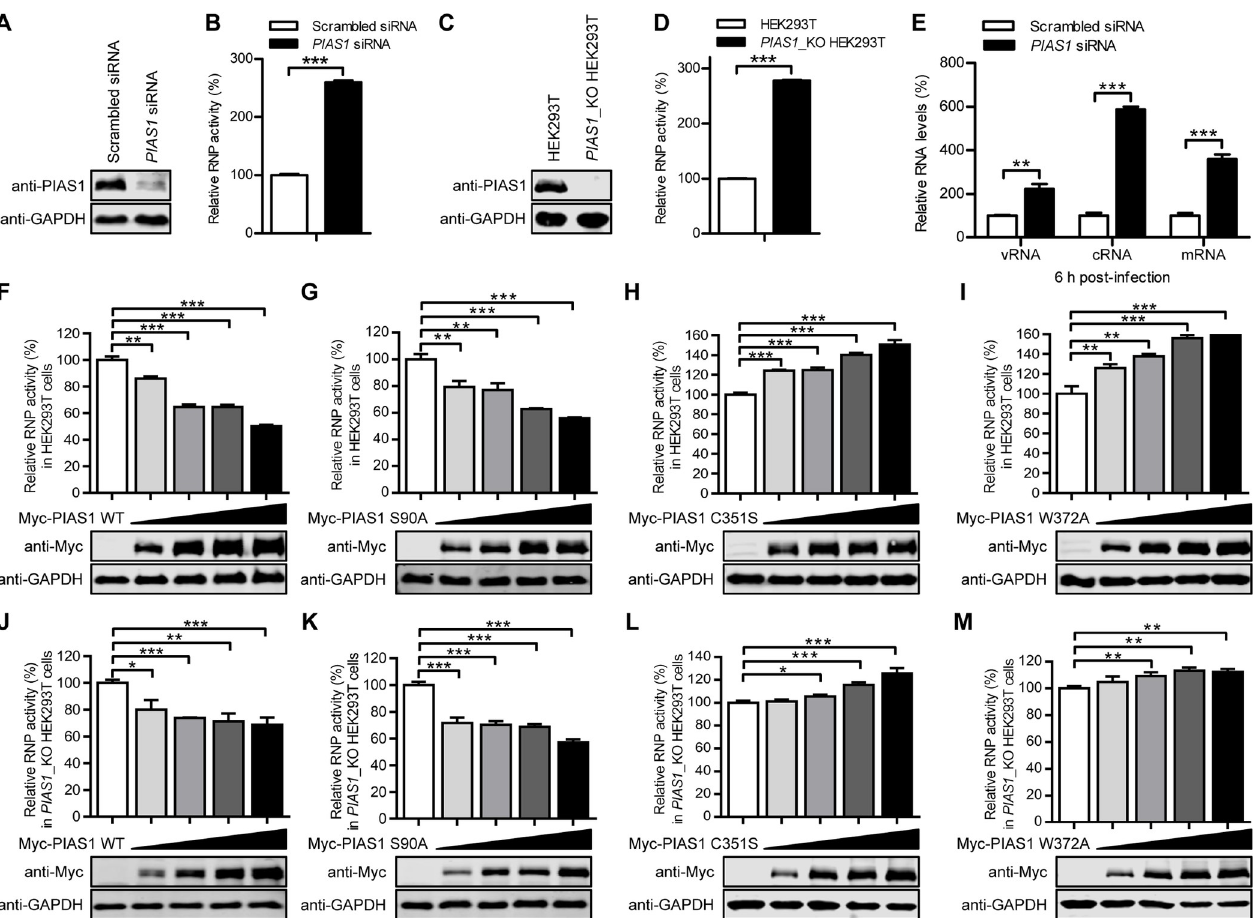
Fig 4. PIAS1 relies on its SUMO E3 ligase activity to suppress IAV transcription and replication. (A) siRNA knockdown of PIAS1 in HEK293T cells. HEK293T cells were transfected with PIAS1 siRNA or scrambled siRNA for 48 h. Knockdown of PIAS1 expression was confirmed by western blotting with a rabbit anti-PIAS1 pAb. (B) Minigenome assay in siRNA-treated HEK293T cells to determine the effect of endogenous PIAS1 on viral RNP activity. HEK293T cells treated with siRNA as in (A) were transfected with plasmids for the expression of four viral RNP proteins (WSNPB2, WSNPB1, WSNPA, and WSNNP), together with pHH21-SC09NS F-Luc and pRL-TK. Thirty-six hours later, a dual-luciferase assay was performed in which the relative firefly luciferase activity was normalized to the internal control, Renilla luciferase activity. ��� , P < 0.001. (C) Establishment of a PIAS1 _KO HEK293T cell line. The knockout of PIAS1 was confirmed by western blotting with a rabbit anti-PIAS1 pAb. (D) Minigenome assay in PIAS1 _KO HEK293T cells to determine the effect of endogenous PIAS1 on viral RNP activity. The minigenome assay was performed in PIAS1 _KO HEK293T cells as in (B). ��� , P < 0.001. (E) RT-qPCR analysis to determine the effect of PIAS1 knockdown on the transcription and replication of viral RNAs. A549 cells were transfected with siRNA targeting PIAS1 or with scrambled siRNA for 48 h, followed by infection with WSN (H1N1) virus (MOI = 5). Total RNA was extracted at 6 h p.i. by using TRIzol reagent, and the levels of NP - specific vRNA, cRNA, and mRNA were analyzed by RT-qPCR and then normalized to GAPDH mRNA. The values shown are standardized to the corresponding RNA expression level in the scrambled siRNA-treated A549 cells (100%). �� , P < 0.01, ��� , P < 0.001. (F-I) Minigenome assay in HEK293T cells to examine the effect of exogenously expressed wild-type PIAS1 and PIAS1 mutants on viral RNP activity. HEK293T cells were transfected with plasmids for the expression of four viral RNP proteins and increasing amounts of Myc-PIAS1 or Myc-PIAS1 mutant, together with pHH21-SC09NS F-Luc and pRL-TK. At 36 h post-transfection, a dual-luciferase assay was performed in which the relative firefly luciferase activity was normalized to the Renilla luciferase activity. �� , P < 0.01, ��� , P < 0.001. (J-M) Minigenome assay in PIAS1 _KO HEK293T cells to examine the effect of exogenously expressed wild-type PIAS1 and PIAS1 mutants on viral RNP activity. The minigenome assay was performed in PIAS1 _KO HEK293T cells as in (F-I). � , P < 0.05, �� , P < 0.01, ��� , P < 0.001.